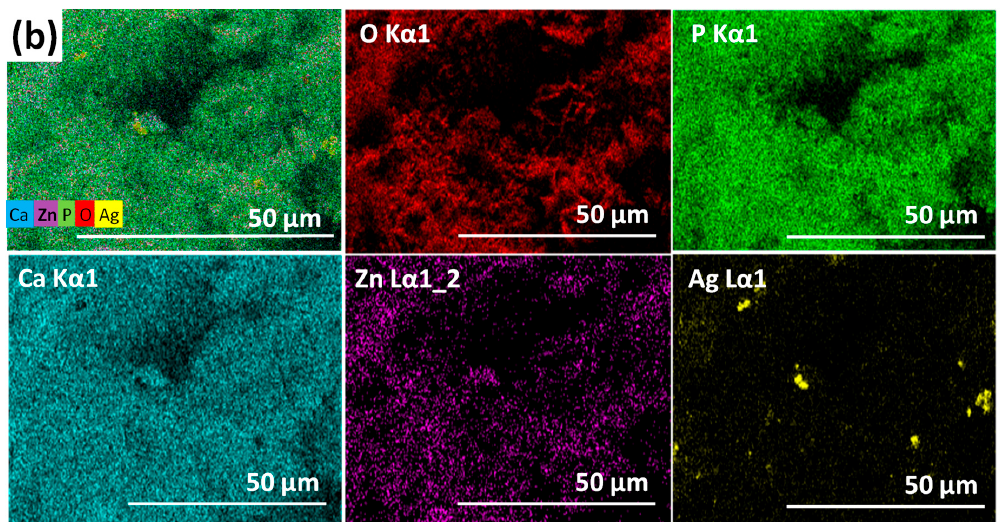
Figure 3. SEM image of silver- and zinc-containing calcium phosphate coating. ( a ) Magnification: 10.0 k, working voltage: 2.0 kV, working distance: 8.0 mm, and the corresponding map sum EDX spectrum (inset) and ( b ) elemental mapping of silver- and zinc-containing CP coating.